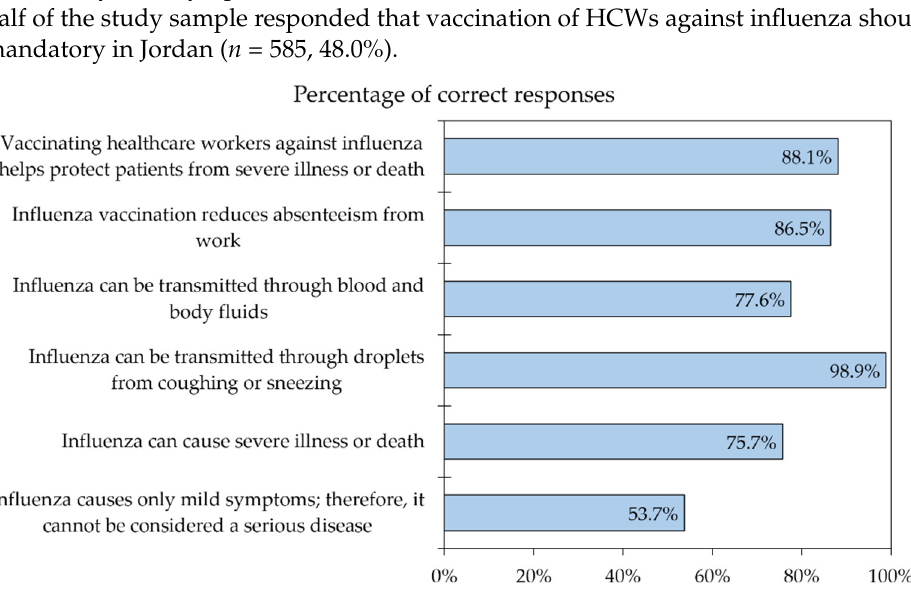
Figure 1. The overall level of knowledge about influenza among the study respondents ( n = 1218).